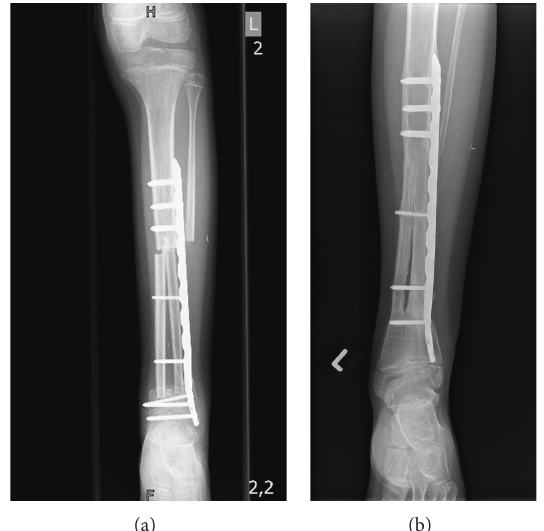
Figure 1: (Patient no. 7) (a) Radiograph of a 9-year-old girl with Ewing’s sarcoma of the distal tibia diaphysis. Defect reconstruction (12cm) was achieved by using bilateral fibular graft and plate osteosynthesis. Due to the small remaining distal epiphyseal fragment the screws had to be placed in the epiphysis. (b) Radiographic results 29 months after tumor resection giving good evidence of bony healing. The epiphyseal screws have been removed. Nevertheless the ankle shows a mild valgus deformity resulting in an MSTS score of 93%.